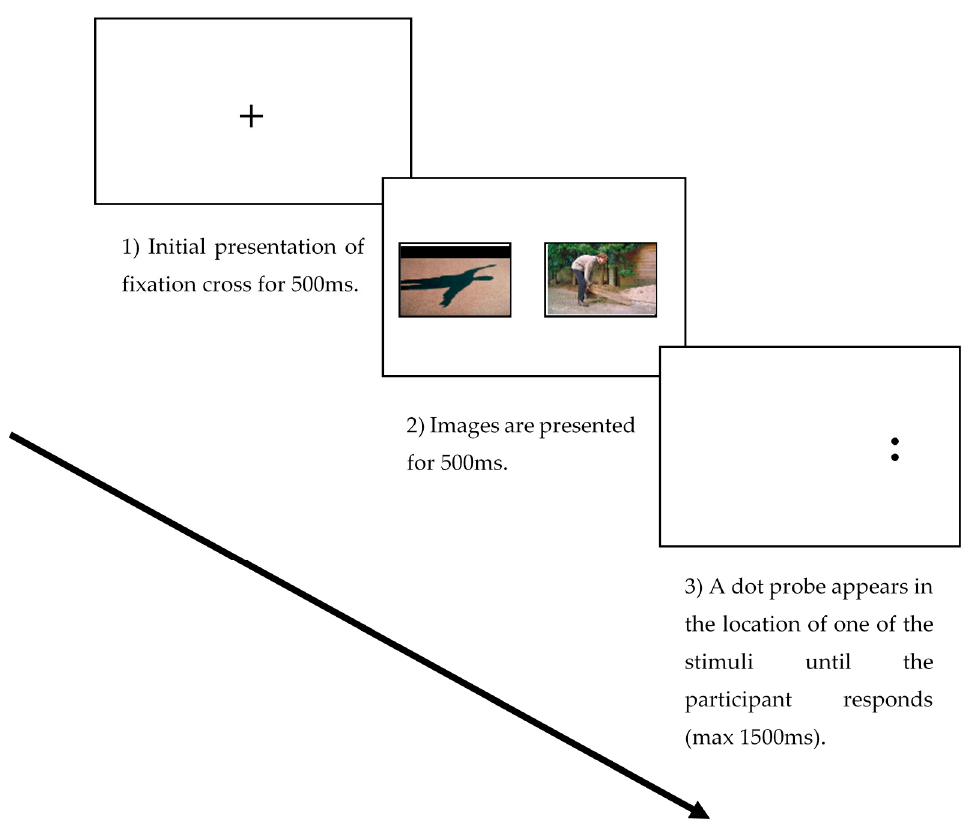
Figure 1. An example of the three stages of the dot probe task in the neutral threat condition.